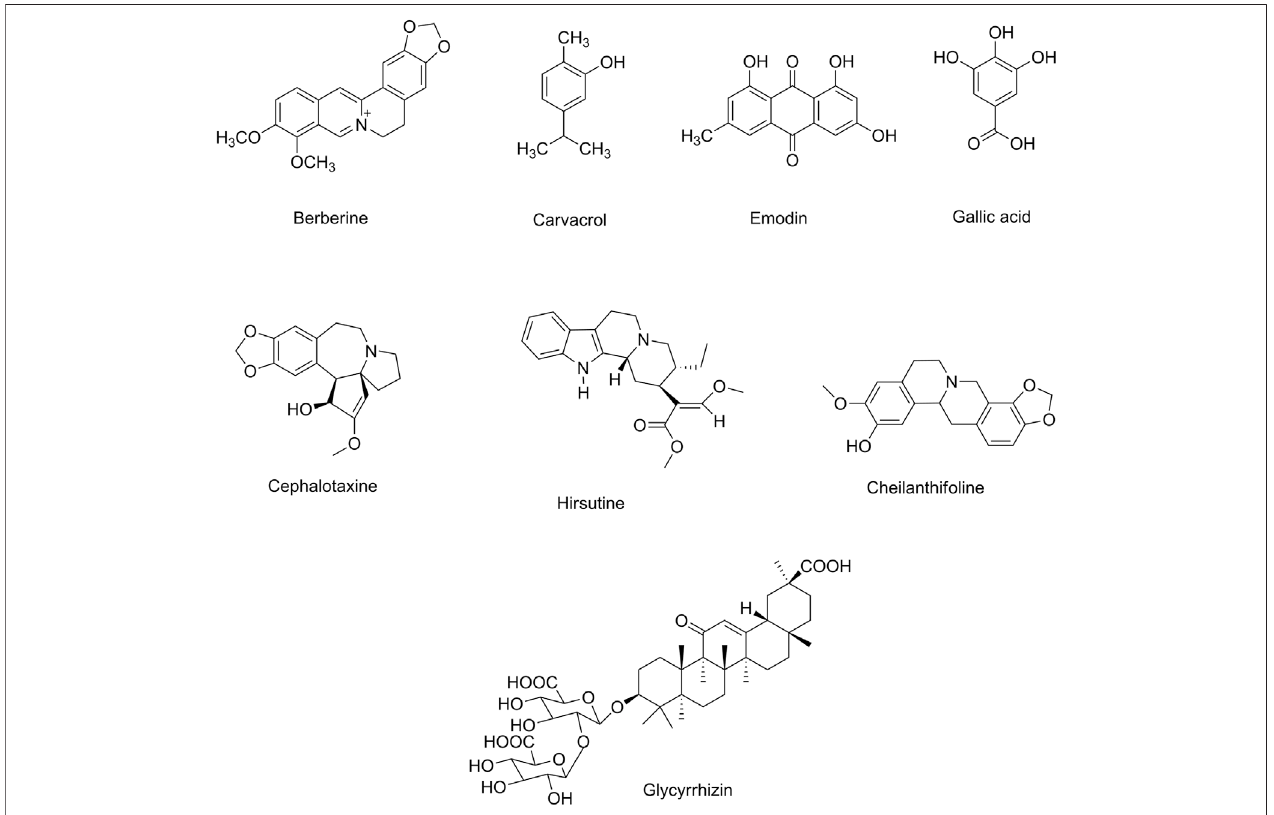
FIGURE 3 | Selected chemical structures of alkaloids and miscellaneous compounds in combating neuronal signs of emerging infectious diseases.